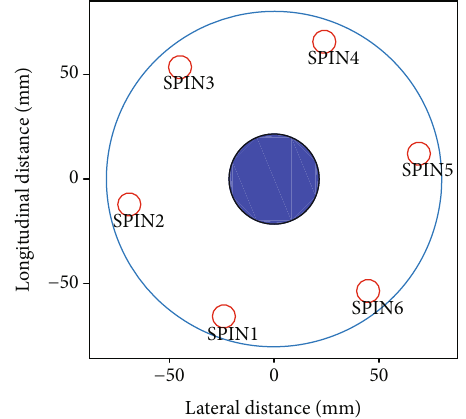
Figure 17: The wellbore distribution map in horizontal well with flow rate = 100 m 3 /d of SAT.